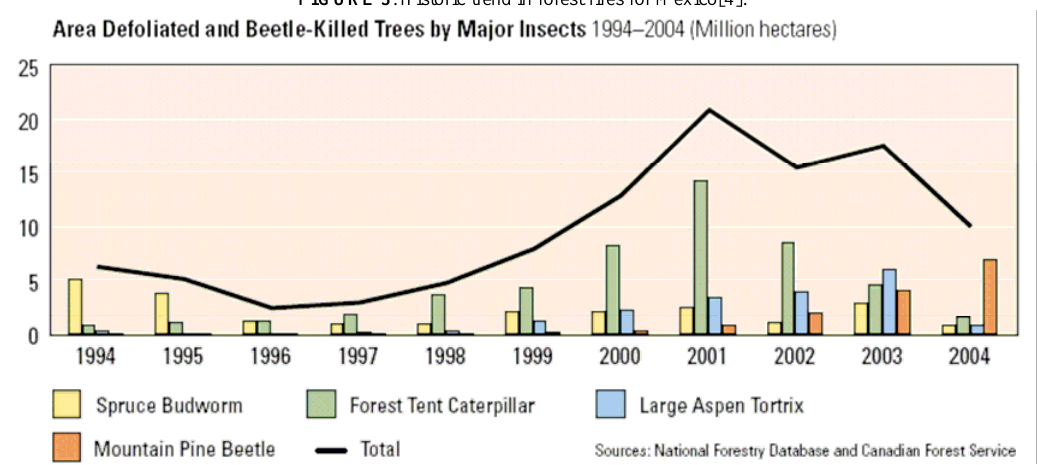
FIGURE 3 . Historic trend in forest fires for Mexico[4].